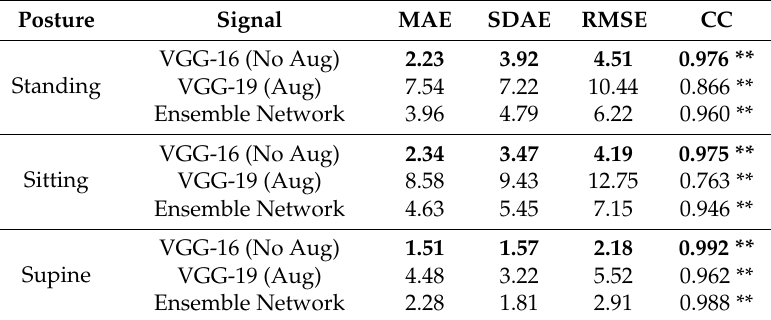
Table 3. Estimation of heart rate in aroused condition by CNNs.